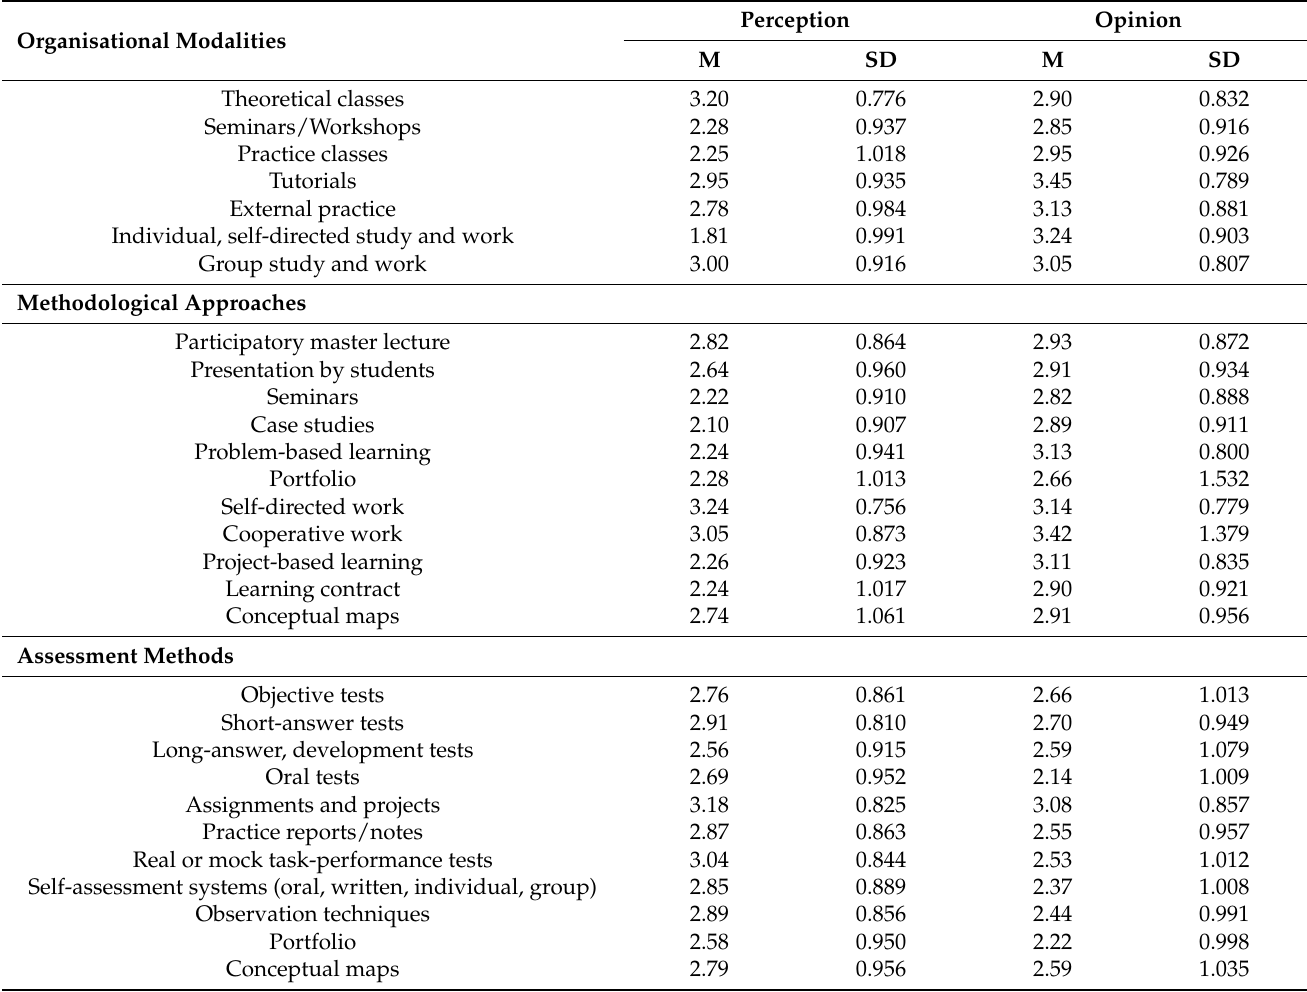
Table 2. The students’ perception (frequent use) and opinion (suitable use) on organisational modalities, methodological approaches and assessment methods (N = 303).